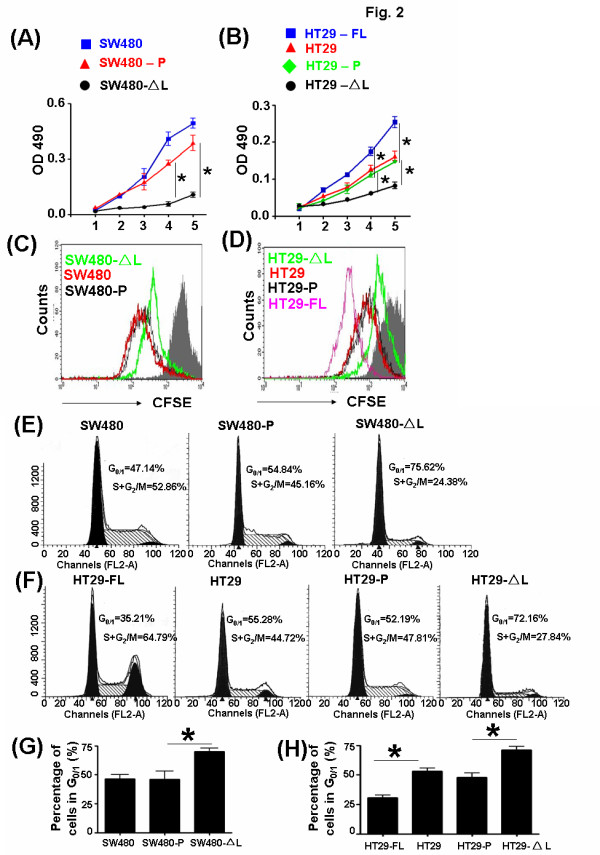
Proliferation of SW480 and HT29 cells was repressed by LEF-1-ΔL. (A) Growth of SW480, SW480-P, and SW480-ΔL cells was compared using the MTT assay. *P < 0.01. (B) Growth of HT29, HT29-P, HT29-ΔL, and HT29-FL cells was compared using the MTT assay. *P < 0.05. (C) and (D) Proliferation of cells in A and B was compared using carboxyfluorescein diacetate–succinimidyl ester staining. (E) and (F) Cell cycle analysis. Cells in A and B were fixed by 67% ethanol and stained with PI, and cell cycle progression was analyzed by FACS. The numbers in the images are the percentages of cells in G0/1 or G2 + M stages. Data represent three independent experiments. (G) and (H) Statistics for the percentages of G0/1 or G2 + M stages in A and B. *P < 0.05.